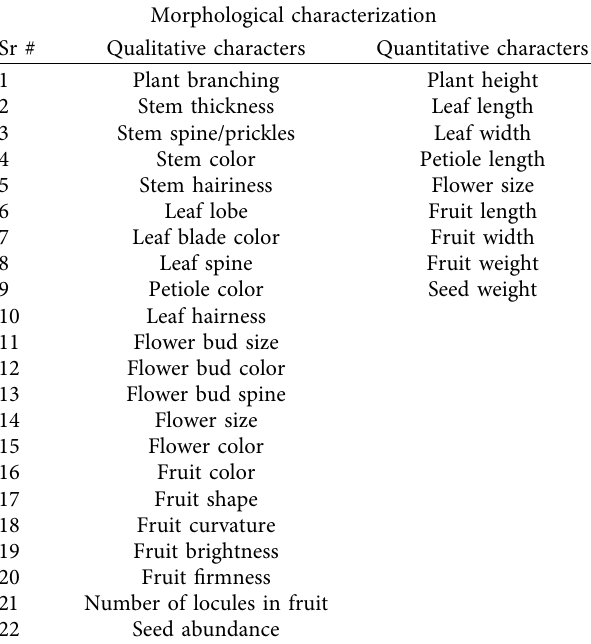
Table 1: Solanum melongena (L) accessions used for diversity